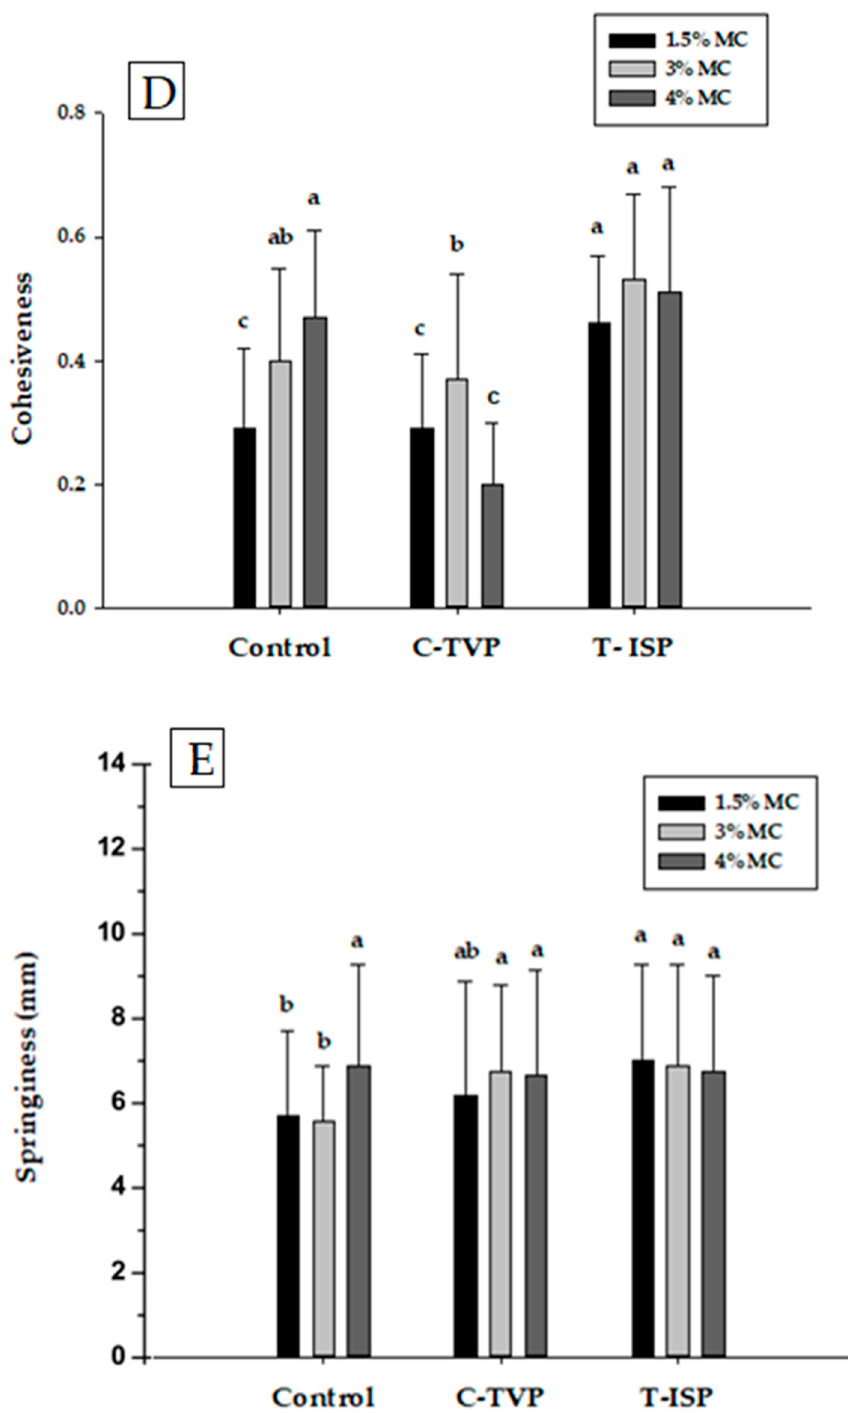
Figure 2. The texture profile analysis (TPA) parameters of plant-based meat on the type of texture soy isolate protein and different methylcellulose concentrations. ( A ) Hardness (N); ( B ) Chewiness (mJ); ( C ) Gumminess (N); ( D ) Cohesiveness; ( E ) Springiness (mm). Those are just different concentrations of MC (Methylcellulose) and the concentration is there on the top right However, in the present study, only springiness values of PBMA patties (TVP and T- ISP) showing marginally or no difference to the control. The hardness and chewiness val-